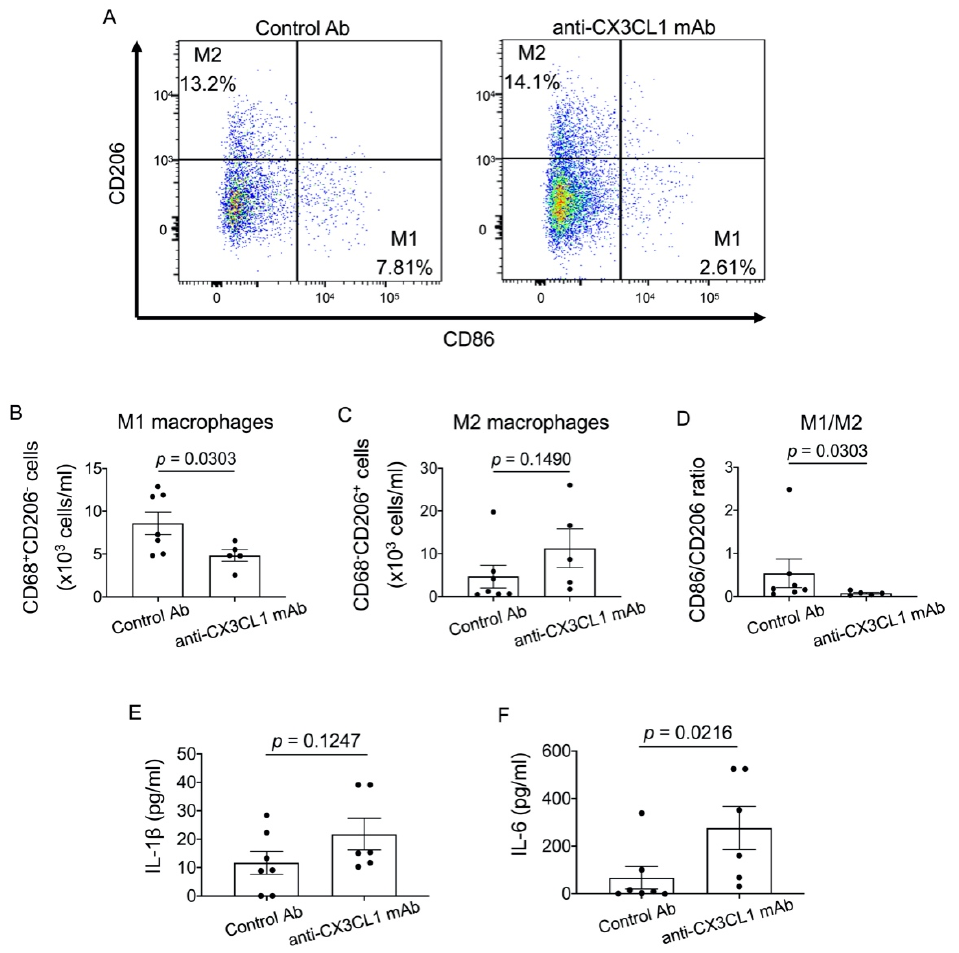
Figure 5. Alterations in M1 and M2 macrophage numbers in BALF following the treatment with anti-CX3CL1 mAb. BALF cells obtained in Figure 4 were analyzed for M1 and M2 macrophages. ( A ) Representative flow cytometry scatter plots for the expression of CD86 and CD206 in CD68 + macrophages. ( B – D ) The numbers of M1 macrophages (CD86 + CD206 - cells; ( B ) and M2 macro- phages (CD206 + CD86 - cells; ( C ) and the M1/M2 ratio ( D ) are shown. ( E , F ) Levels of interleukin (IL)-1 β ( E ) and IL-6 ( F ) in BALF. Data are expressed as means ± SEM. The Mann–Whitney U test was performed.